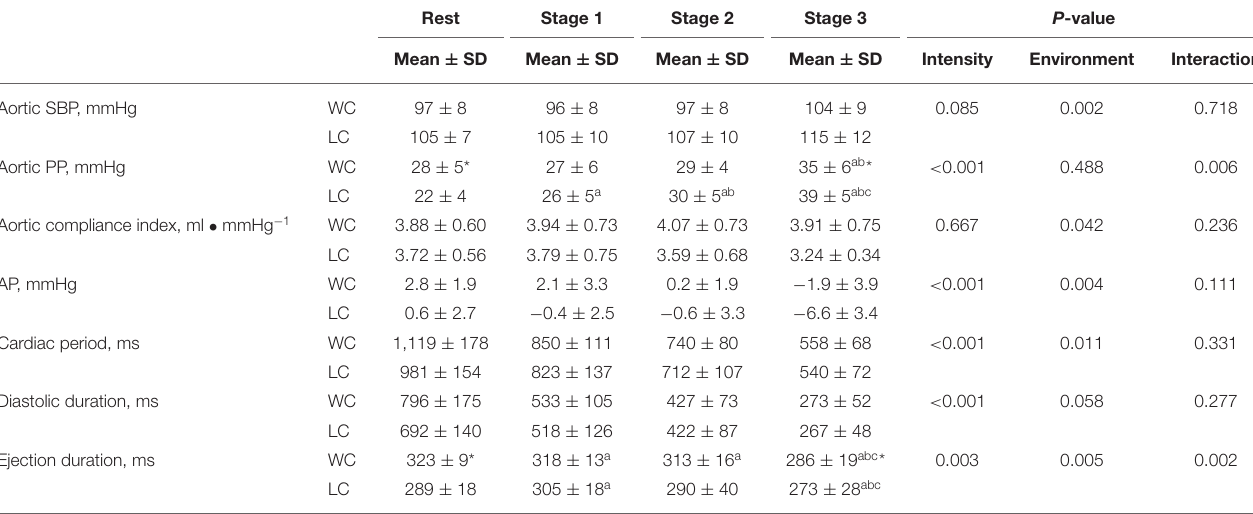
TABLE 3 | Aortic hemodynamics at rest and during exercise.